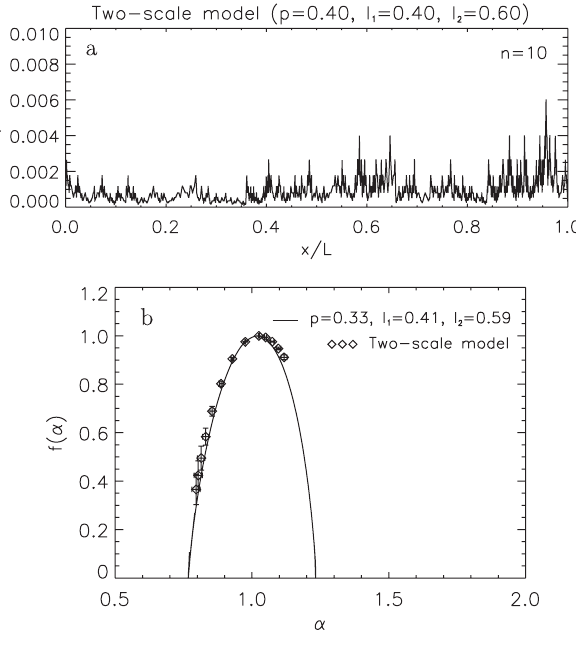
Fig. 1. (a) The theoretical multifractal measure µ = ε/ h ε L i on the unit interval for twelfth step of the construction of the usual one- scale Cantor set. (b) The multifractal spectrum f (α) obtained di- rectly for this measure (diamonds) with a fit (dashed line) to the p -model.